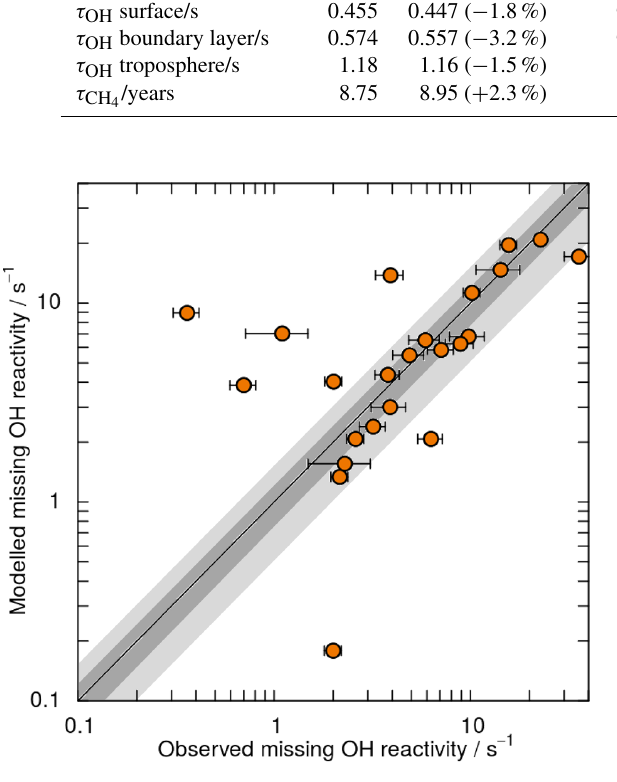
Figure 4. Scatter plot of missing OH reactivity modelled by multi- ple linear regression against observed missing OH reactivity (as re- ported in Table 2). Each point represents one observation site. The error bars mirror the uncertainties (at the 1 σ level) from each indi- vidual measurement of the total k OH . Also shown is the 1 : 1 line (solid line), as well as the 20 and 50% deviations from it (dark-grey and light-grey areas respectively). The R 2 value from the multiple linear regression was 0.75.